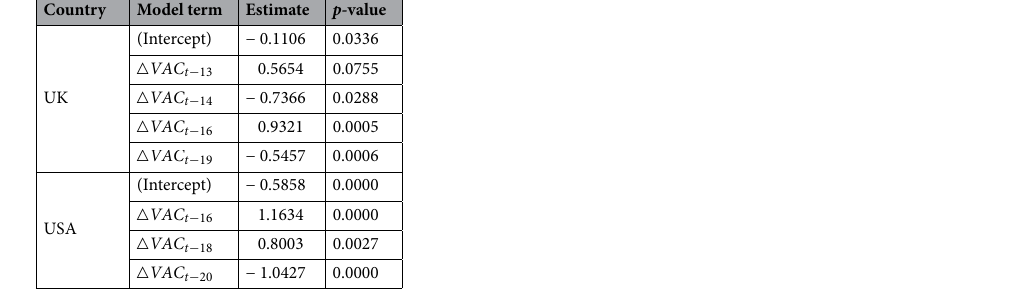
Table 2. Distributed lag model for ICU admission ( △ ICU ) in UK and USA. Here, the intercept term refers to α in Eq. (4).